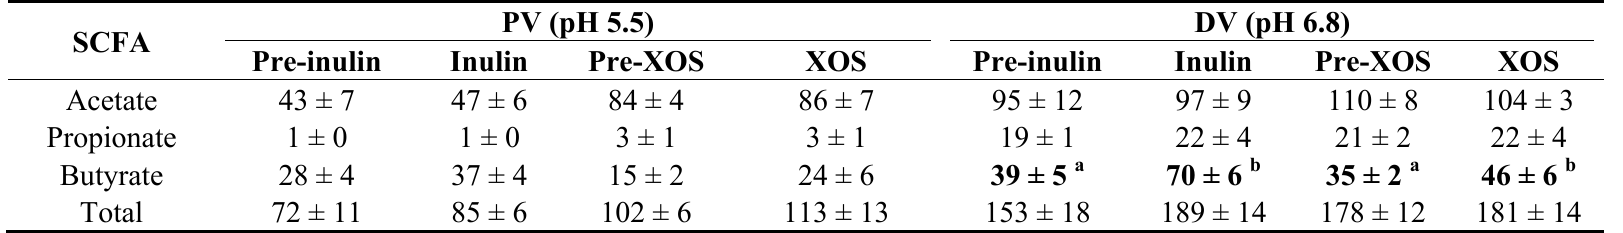
Table 3. Short chain fatty acid (SCFA) concentrations. SCFA (µmoL/g) are presented as the mean ± SEM and measured in vessels after fermentation of low amylose cornstarch (pre-inulin and pre-XOS), inulin and XOS in a human colonic simulator. PV: proximal vessel; DV: distal